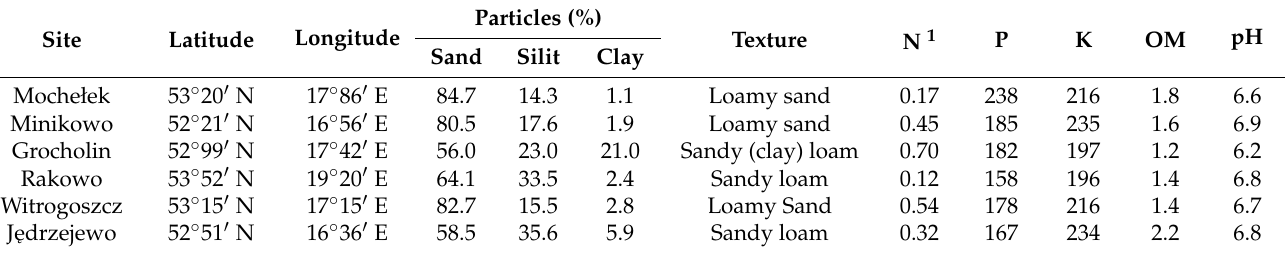
Table 1. Coordinates and soil characteristics of the study